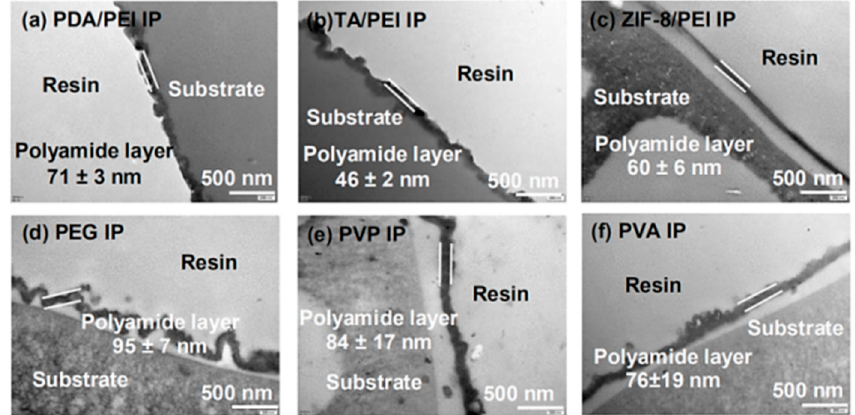
Figure 4. Transmission electron microscopy (TEM) observation of thickness of the formed polyamide layer on the ( a – c ) PSf substrates with various modified interlayers and ( d – f ) the doped polyamide layer with the macromolecular additives in the aqueous solution of PIP.